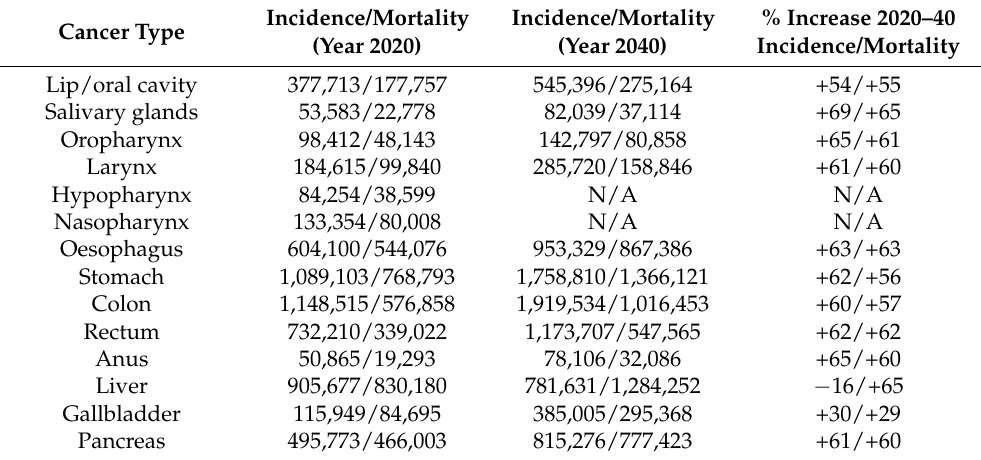
Table 1. Cancers of the digestive system: patient incidence and mortality estimates worldwide for the year 2020 and projected increase in 2040 [1]. Incidence/Mortality Incidence/Mortality % Increase 2020–40 Cancer Type (Year 2020) (Year 2040)